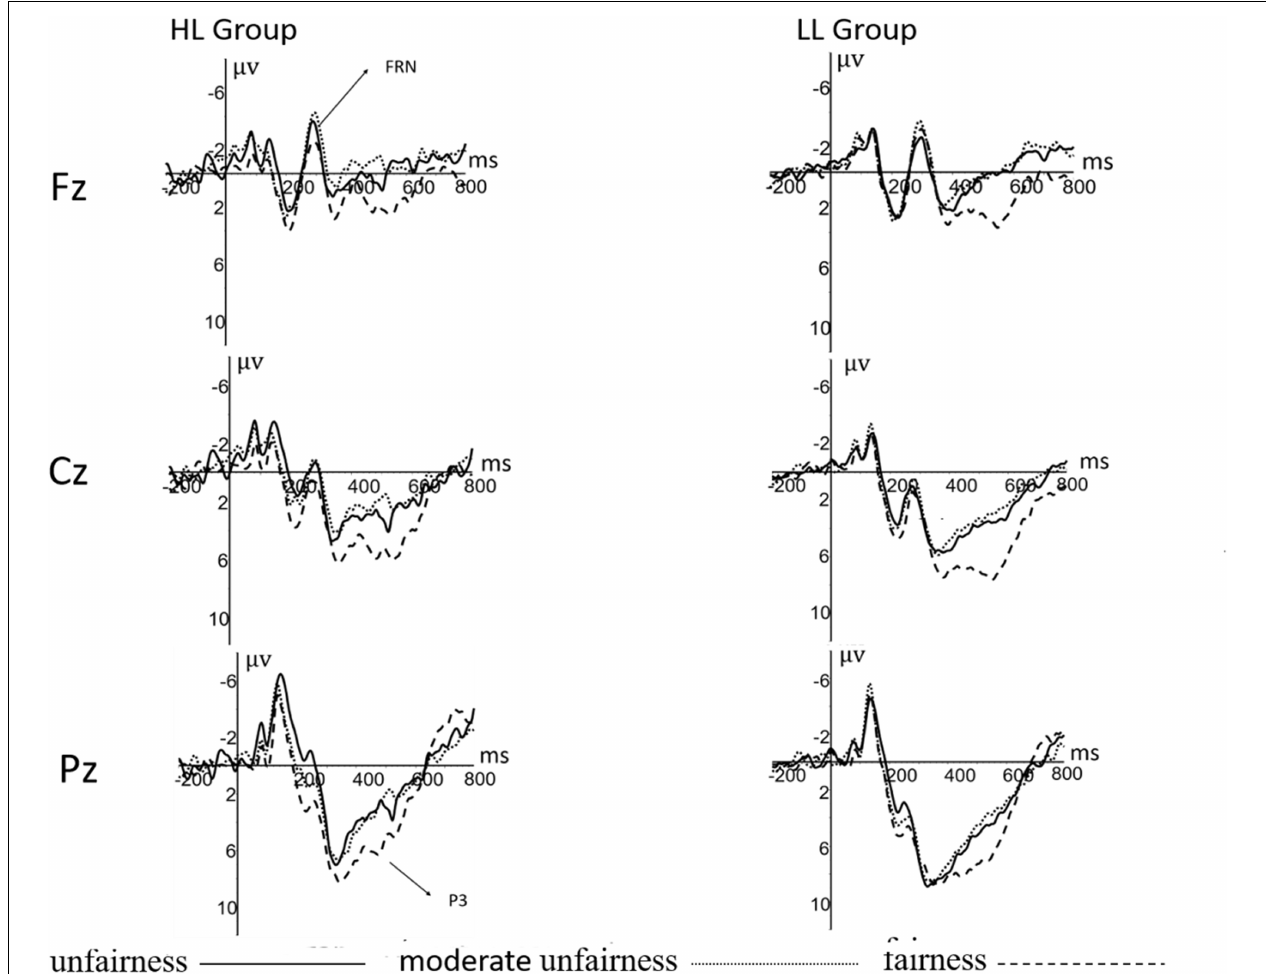
FIGURE 4 | P3, FRN components at Fz, Cz, Pz electrodes when the partner is